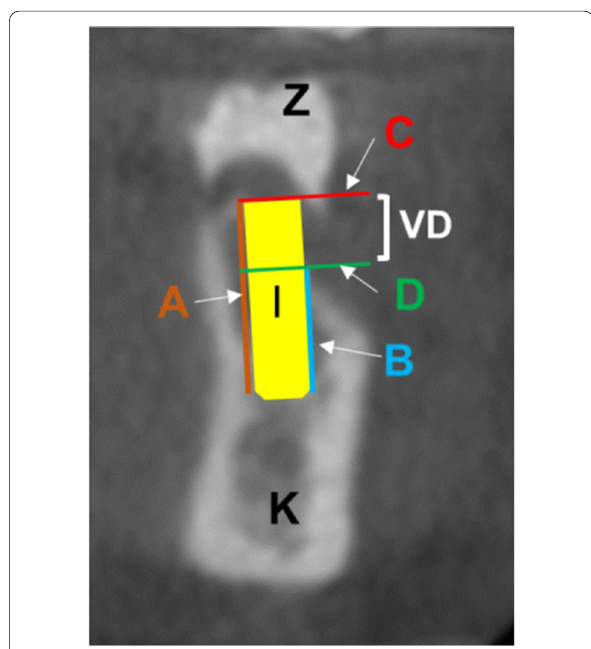
Fig. 5 CBCT coronally slice: A and B lingual and buccal lines parallel to the implant axis, C and D lines perpendicular to A and B in order to determine the vertical distance (VD), K jawbone, I of the virtually planned implant